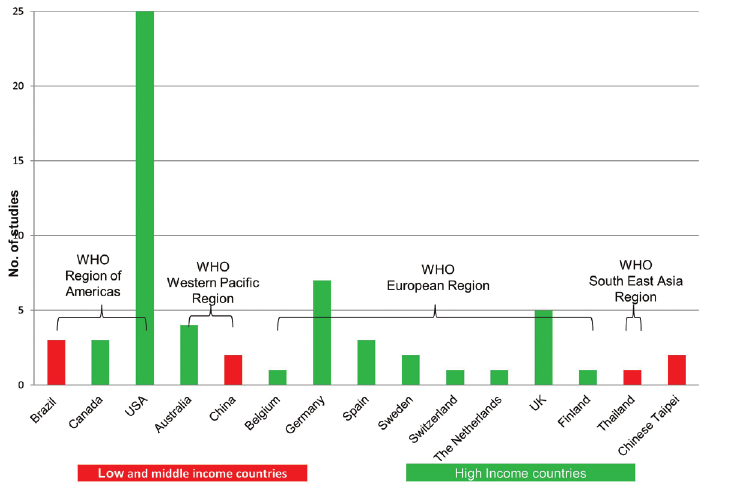
Figure 2. Country of origin of included, examined studies for low– and middle–income and high income countries